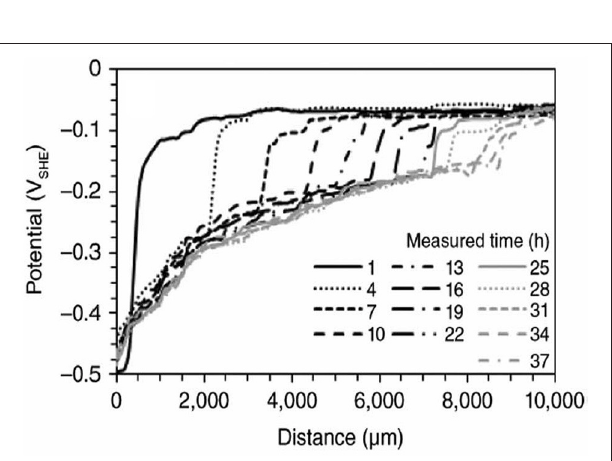
FIGURE 4 | SKP potential profiles of epoxy-coated steel sample. The exposure was carried out using 0.5M Na 2 SO 4 solution as function of distance from the defect (left hand side) for different times of exposure (Milosev and Frankel, 2018).